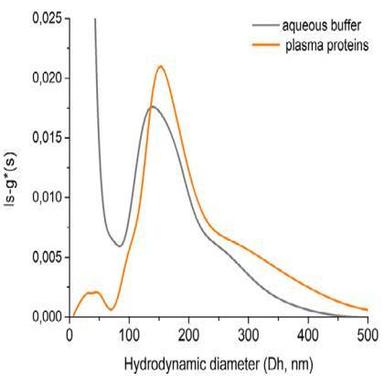
Analysis of API-Polymer NP conjugate in aqueous buffer and after incubation with plasma proteins. A) PSD by intensity by batch DLS. B) UV-VIS fractrogram (detected at 490 nm) vs time. C) Light-scattering intensity and Dh vs time with and without plasma proteins. The blue arrow indicates the increase of the void peak in presence of plasma proteins. D) Sedimentation profiles and E) PSD by AUC with and without plasma proteins. F) Summary table reporting the measured size and % of API fractions not encapsulated